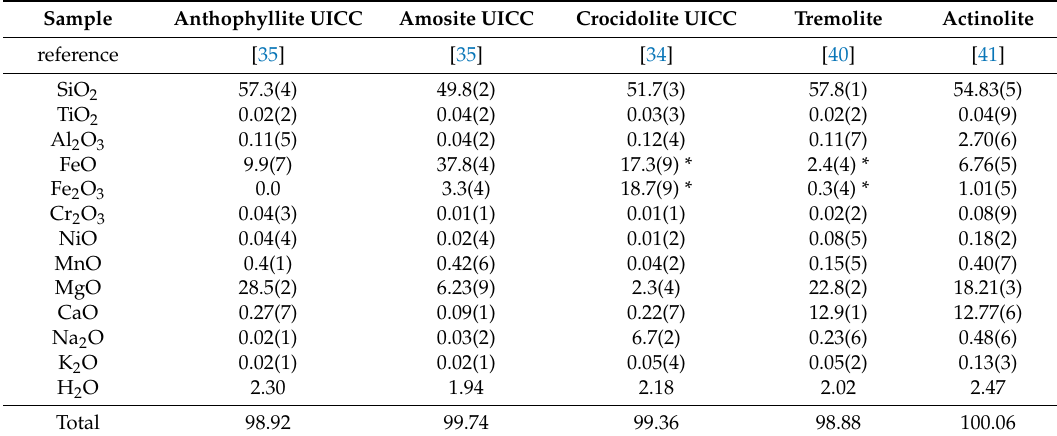
Table 3. Microchemical data for the studied reference amphiboles. * Partition determined from Mössbauer spectroscopy